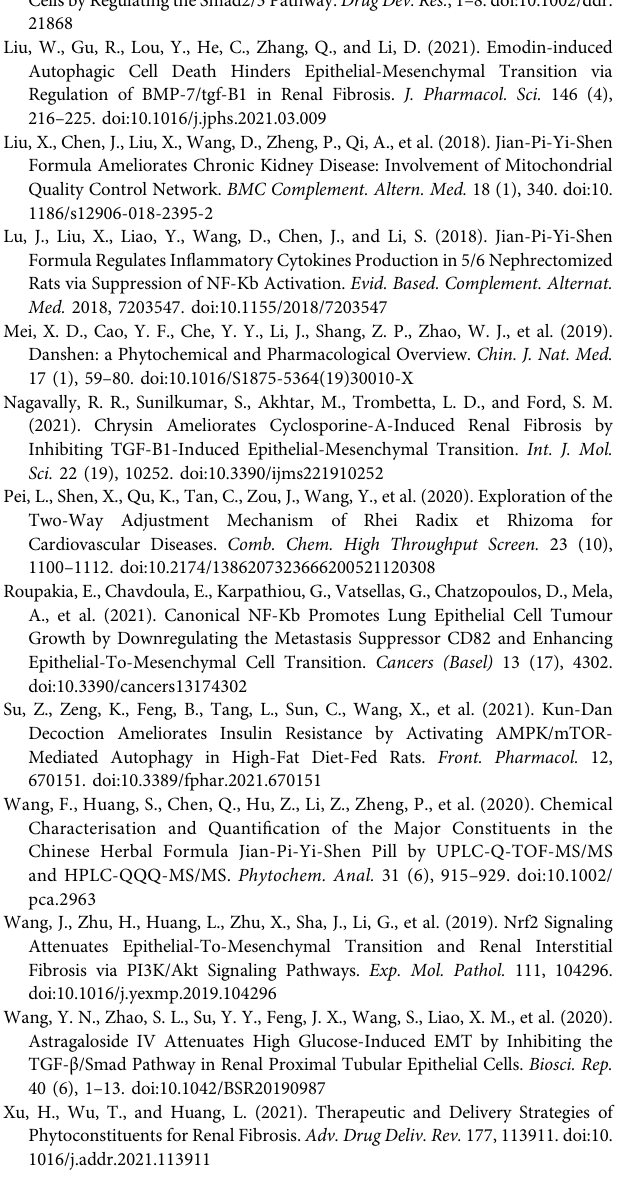
Supplementary Figure S1 | HPLC-MS chromatograms of JPYSF extract. The notations are as follows: 1: Acteoside; 2: Calycosin 7-O-glucoside; 3: Liquiritin; 4: Rosmarinic acid; 5: Salvianolic acid A; 6: Calycosin; 7: Astragaloside IV; 8: Formononetin; 9: Rhein; 10: Dioscin; 11: Atractylenolide I; 12: Tanshinone